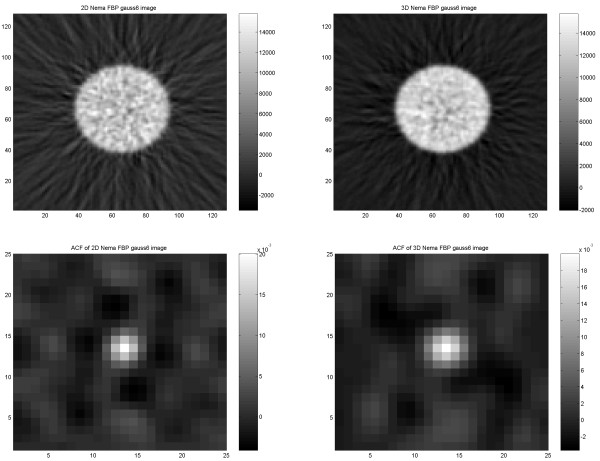
Results of the cylindrical NEMA phantom study. 2D acquisition image (upper left) and 3D acquisition image (upper right) reconstructed using FBP with applied 6 mm (FWHM) Gaussian filter. Corresponding ACF images of 2D (lower left) and 3D image (lower right).